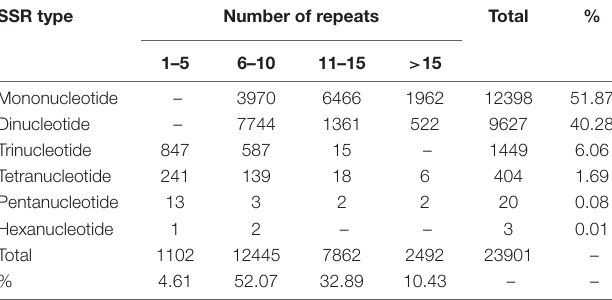
TABLE 4 | Frequency distributions of SSRs in elongate loach transcriptome based on the number of repeat